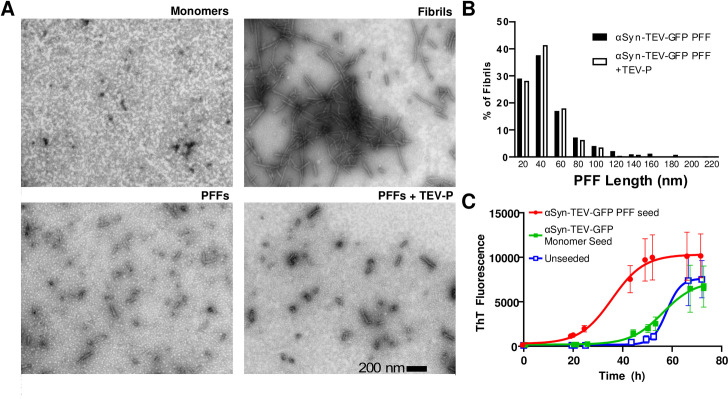
Characterization of α-syn-TEV-GFP pre-formed fibrils and seeding efficacy.(Panel A) Electron microscopy images of negatively-stained α-synuclein monomers, intact fibrils, sonicated fibrils, and sonicated fibrils following TEV treatment. (Scale bar = 200 nm). (Panel B) Histogram of fibril size distribution after sonication with and without TEV treatment (bin size 20 nm; >200 fibrils counted for each condition). (Panel C) α-syn-TEV-GFP PFFs are competent to seed the fibrillation of α-synuclein monomers. Thioflavin T fluorescence, generated following fibril formation, is shown.